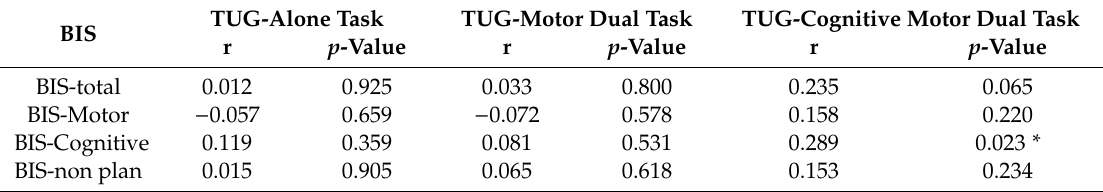
Table 3. Correlation of three types of TUG task performance according to each impulsiveness type. TUG-Alone BIS